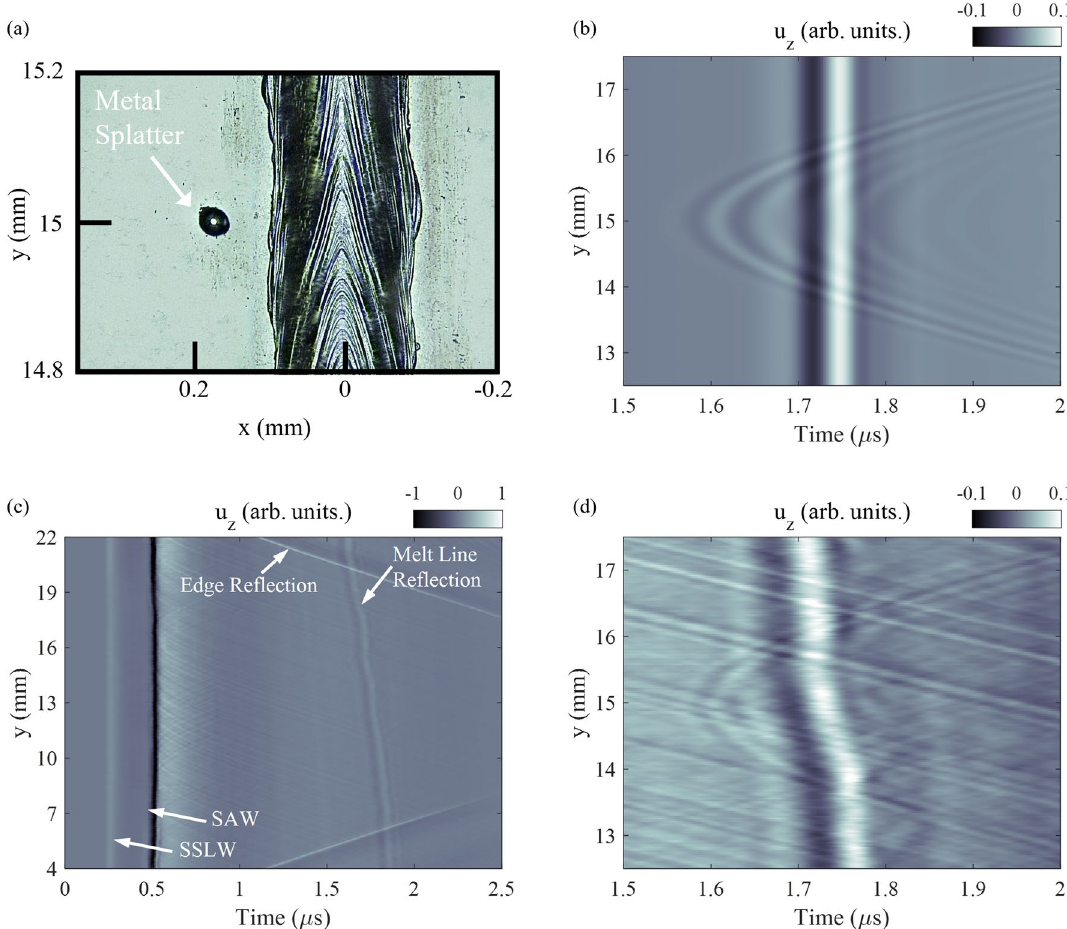
Figure 6. ( a ) Confocal microscope image of metal spatter that occurred during the laser melting processing. The metal spatter is located approximately 200 µ m from the melt line and is indicated with an arrow. ( b ) Simulation of displacement near metal spatter. Parabolic scattering is observed prior to the melt line reflection. ( c ) Experimentally measured normal displacement while scanning along the y-axis of the sample. ( d ) Zoomed-in portion of the image in ( c ) showing parabolic scattering from metal spatter prior to the melt line